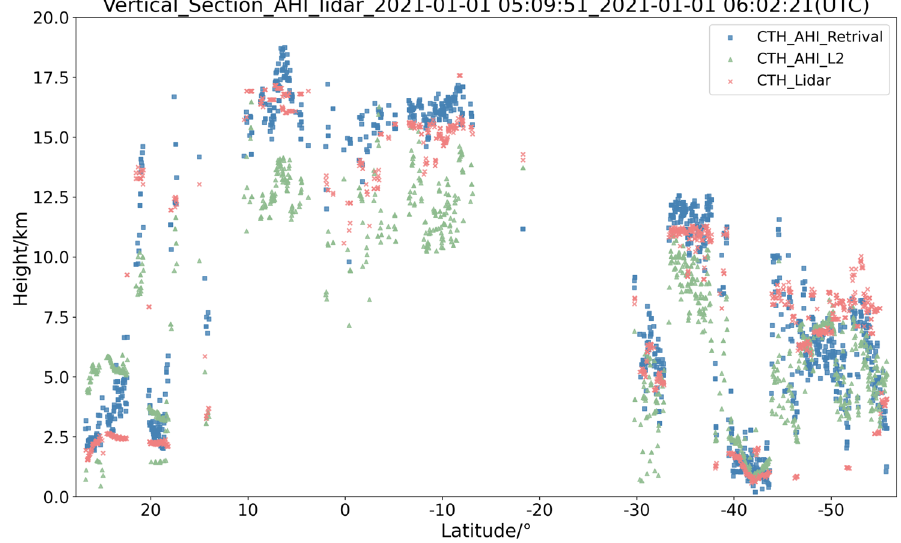
Figure 5. Comparison of CTH